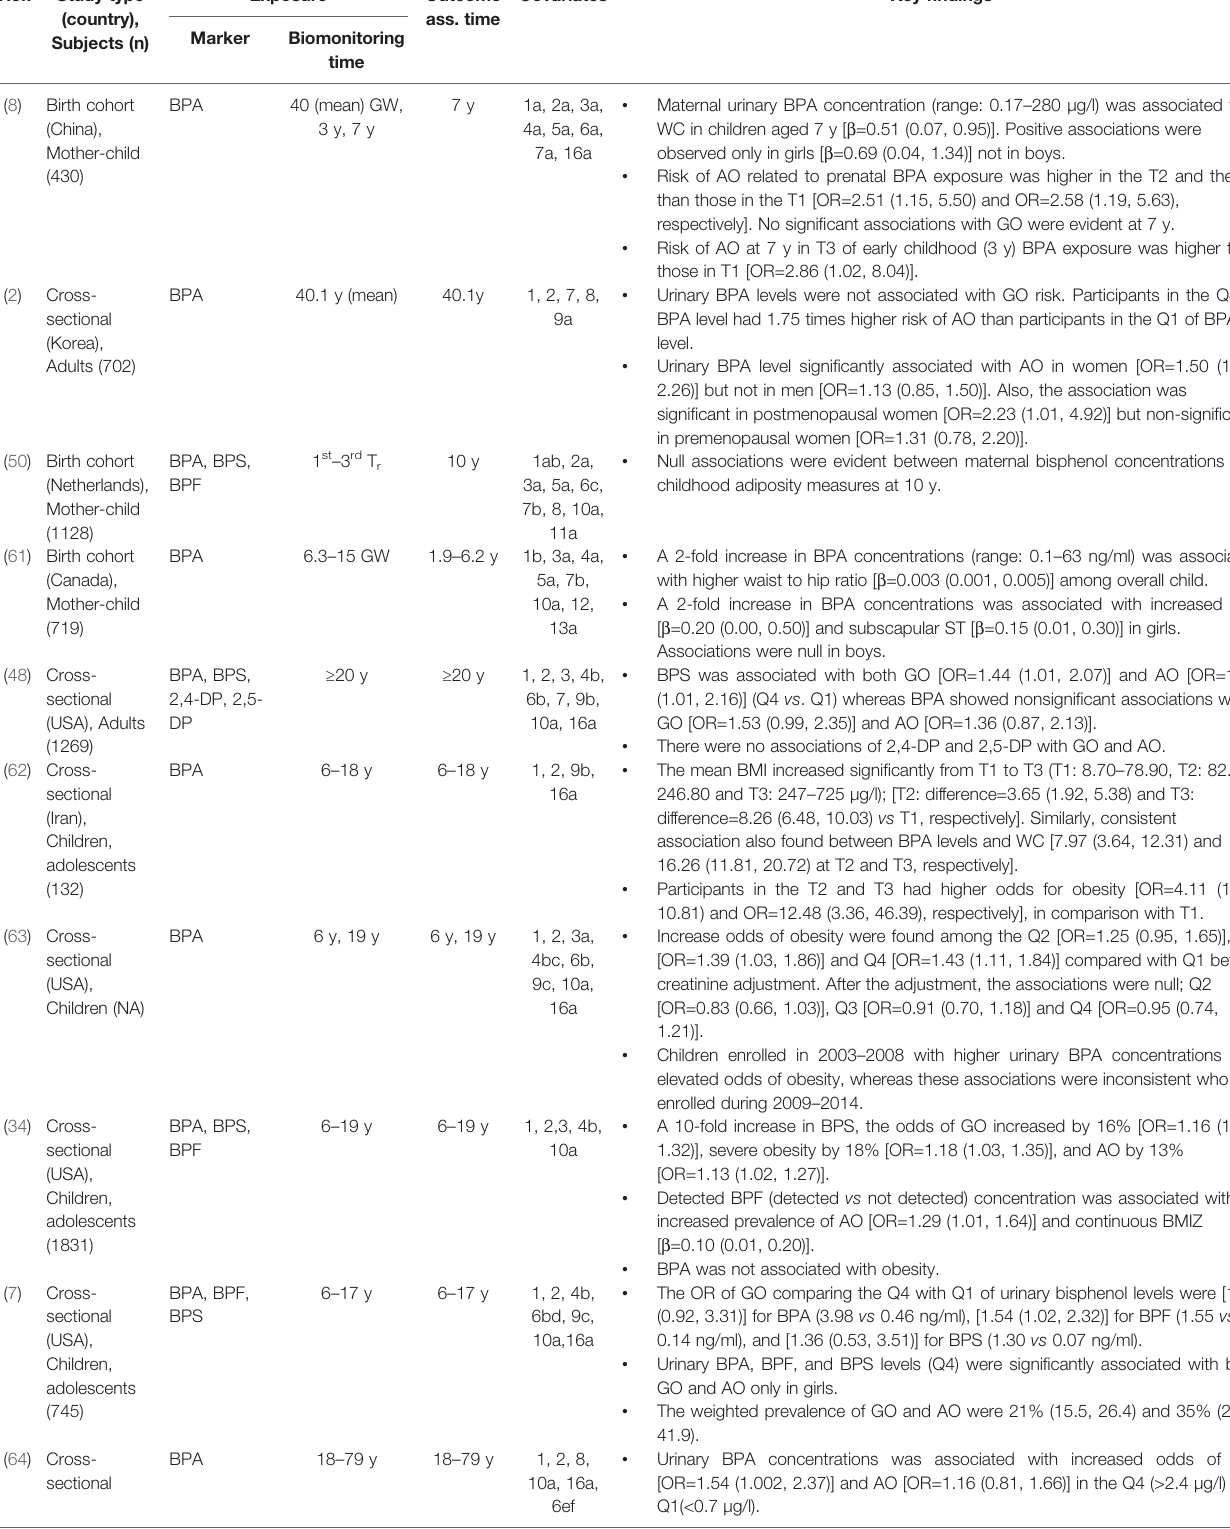
TABLE 1 | Associations of environmental phenols with anthropometric overweight and obesity indices.